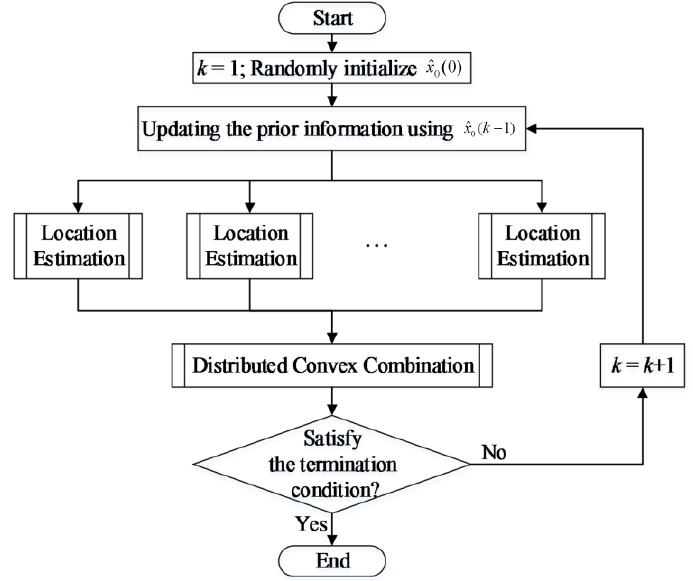
Figure 3. The flow chart of the proposed localization method. The location estimations are conducted locally on all of the sensor nodes which have measured above-threshold ˆ ( ) k x is the global estimate at the k -th iteration of concentration values. 0